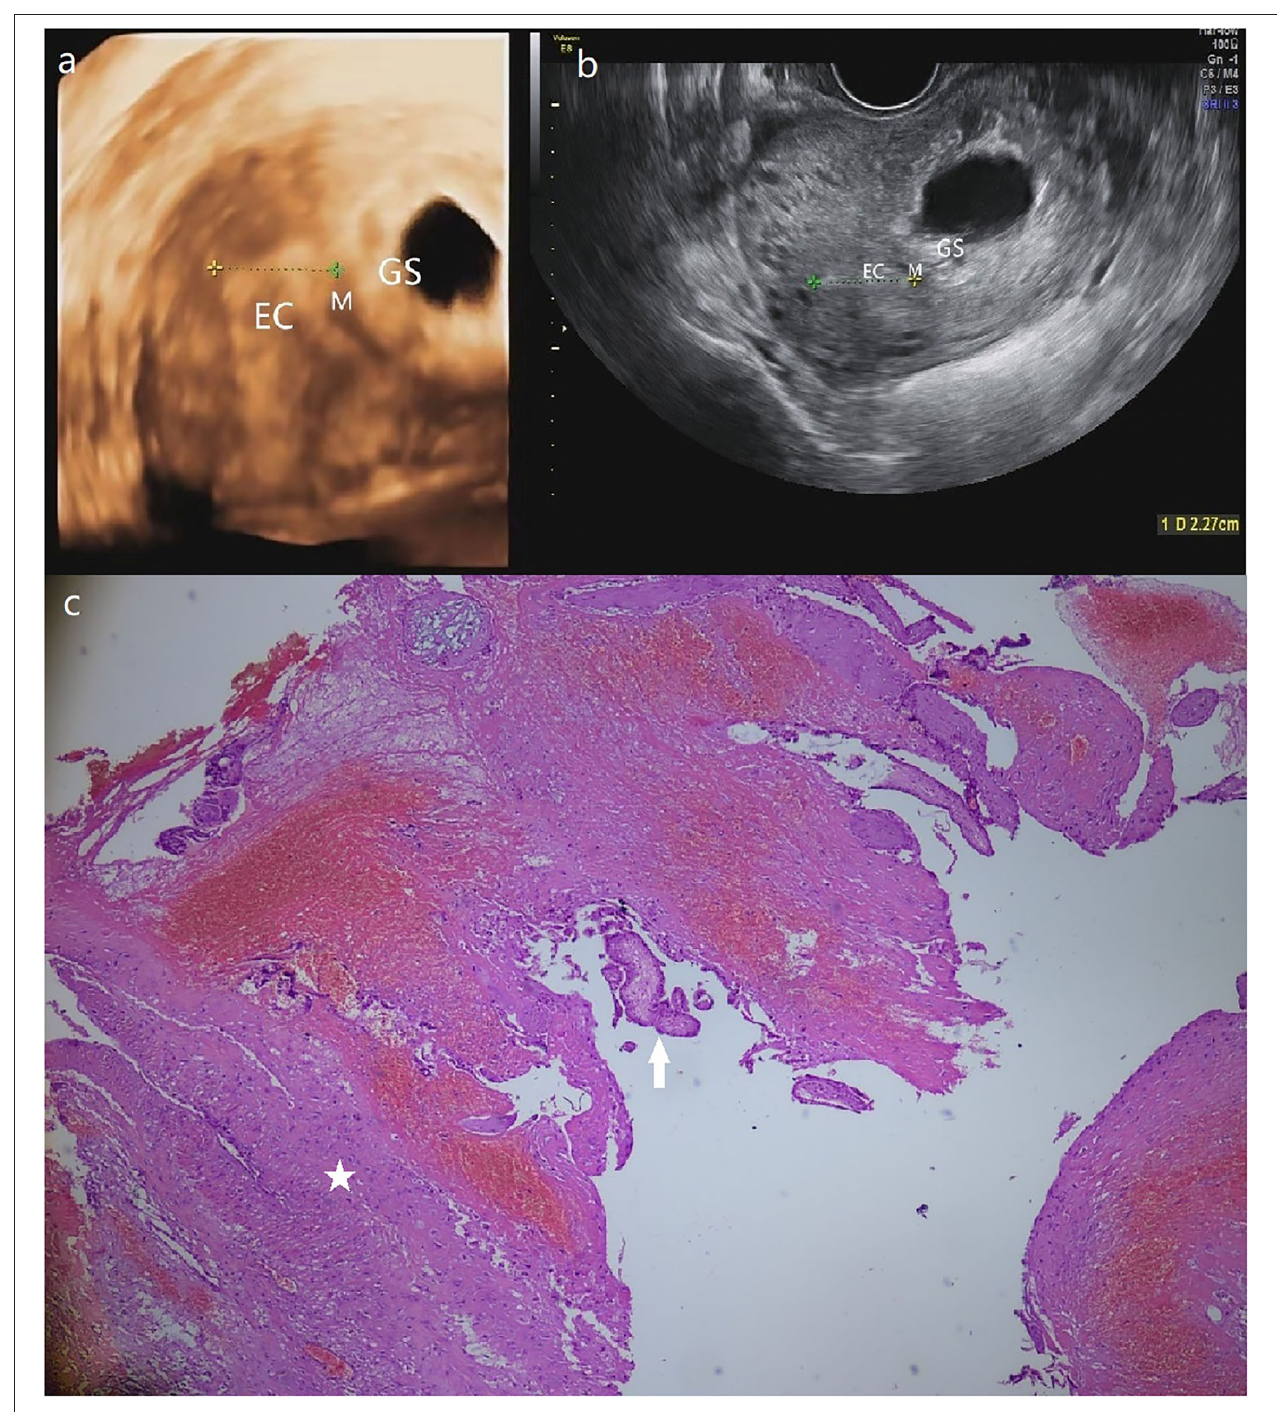
FIGURE 3 | (a) The GS in a size of 4.9*3.4cm is detected in a heterogeneous echo mass of 6.1*4.5cm at the left posterior uterine wall near the left corner of the 3-D ultrasound. (b) Transversal section image in 2-D ultrasound demonstrates the intramural pregnancy and shows that the GS has no communication with EC. (c) The pathological result shows the myometrium (star) and the chorionic villus (arrow). (Patient 3, GS, gestational sac; M, myometrium; EC, endometrial cavity).